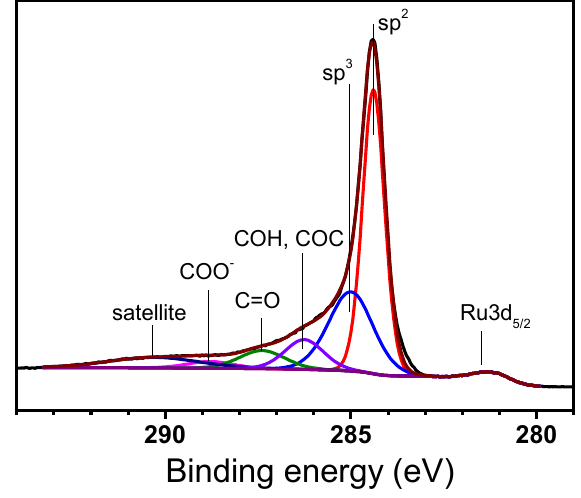
Figure 2. C 1 s spectrum of the 3RS450. Table 4. Results of noncatalytic and catalytic hydrogenation of flax shive in subcritical ethanol at 225 ◦